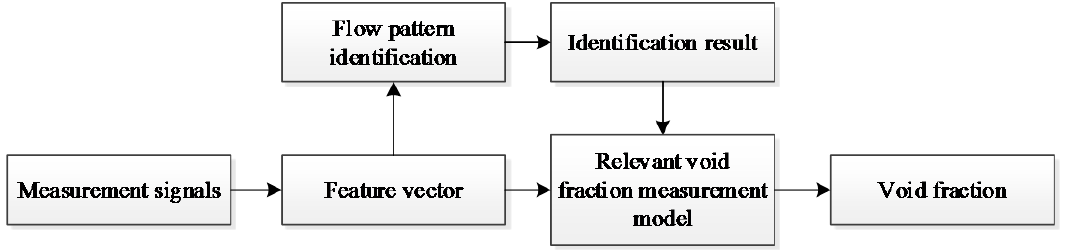
Figure 2. The scheme of the void fraction measurement.